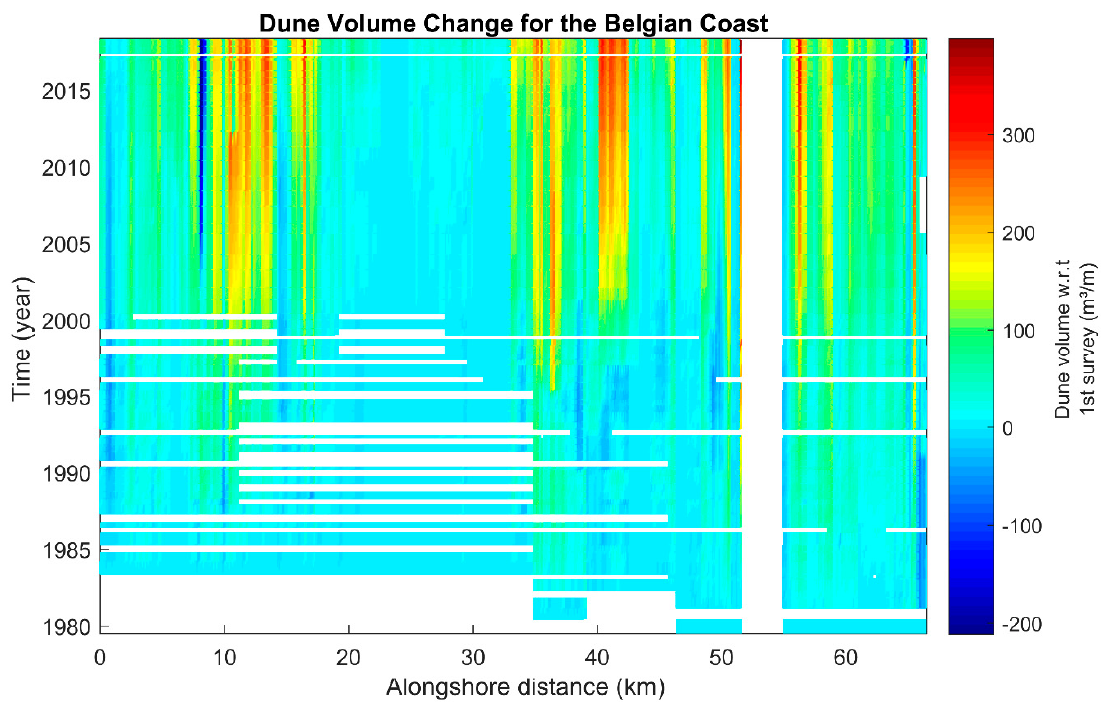
Figure 7. Overview of available data on dune volume with respect to the first survey along the Belgian coast, based on the annual surveys (positive values = deposition; negative values = erosion; 0 = stable). The term dune volume has been defined purely based on bounding planes. Dune volume can also be calculated in areas with a seawall or with artificially raised touristic berms, where no vegetated dunes are found.